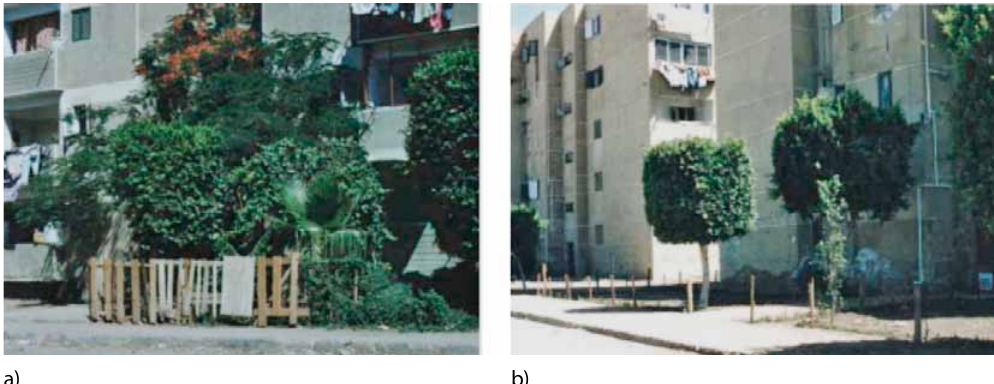
fig. 7a, b: Some examples of the residents’ appropriation of the fina’s for gardening as a significant